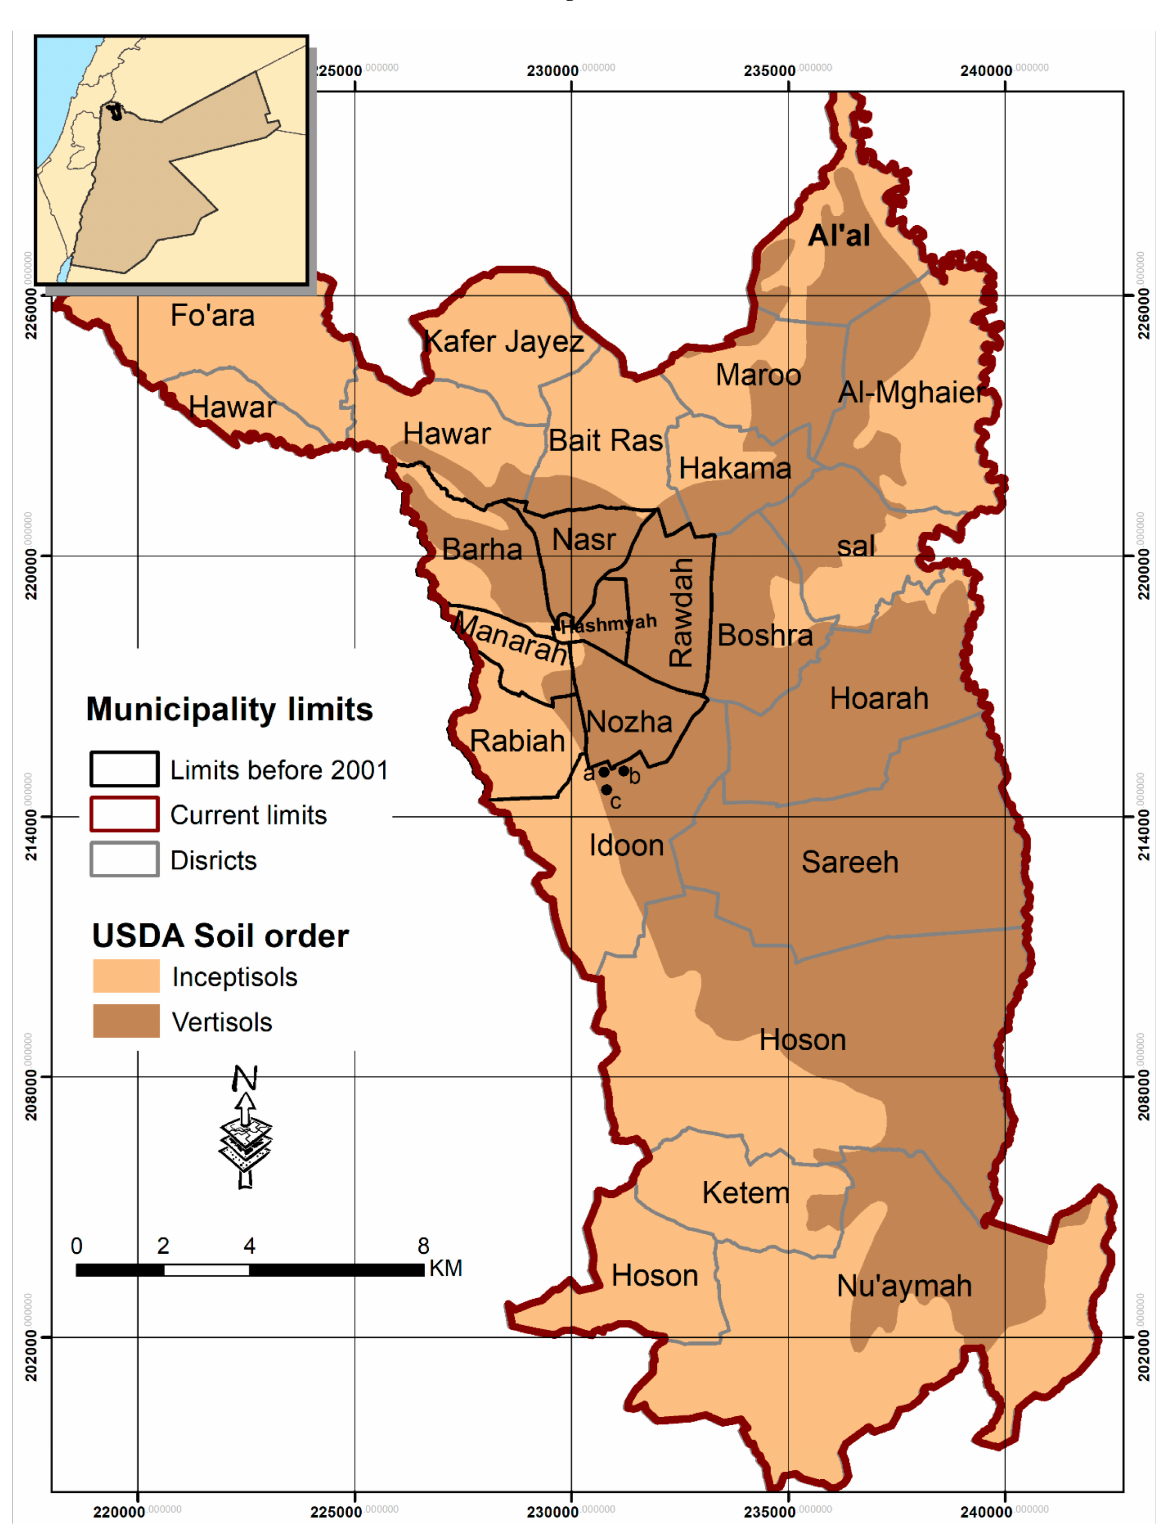
Figure 1. Greater Irbid Municipality (GIM) study area overlaid on top of the soil map. Points a, b, and c denote the three 6 sites visited for accuracy assessment of SLEUTH prediction